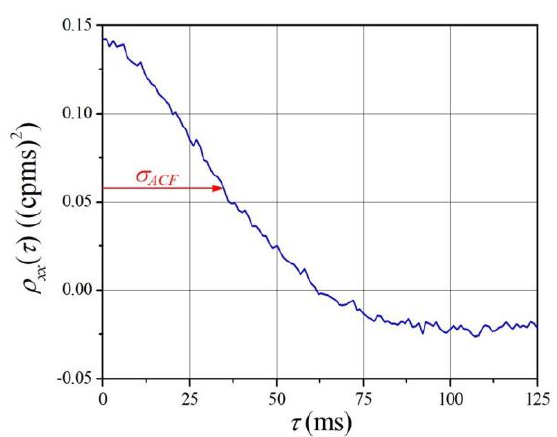
Fig. 3 . Analyzed fragment of ACF from Fig. 2.